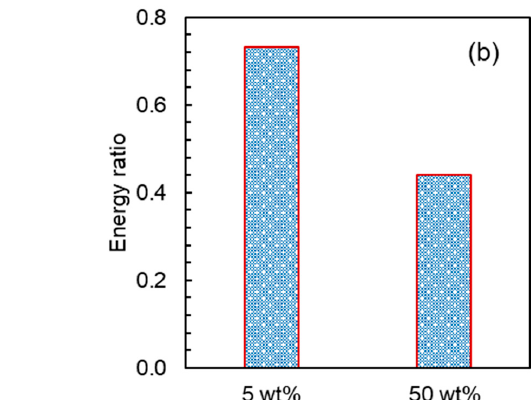
Figure 10. ( a ) Interaction energies between DMF and HPMC(AS) and ( b ) energy ratio: DMF– HPMC(AS)/DMF–DMF at 5 and 50 wt% DMF. The release phenomena of an API from solid dispersion could e ffi ciently be illus- trated by dynamics of the API in solid dispersion. Usually, the dynamics of a molecule in a mixture environment is evaluated by mean-squared displacement (MSD) [62,63]. Not only the dynamics, but also the di ff usion modes of a molecule/particle can be character- ized by MSD [64]. The MSD is quanti fi ed as